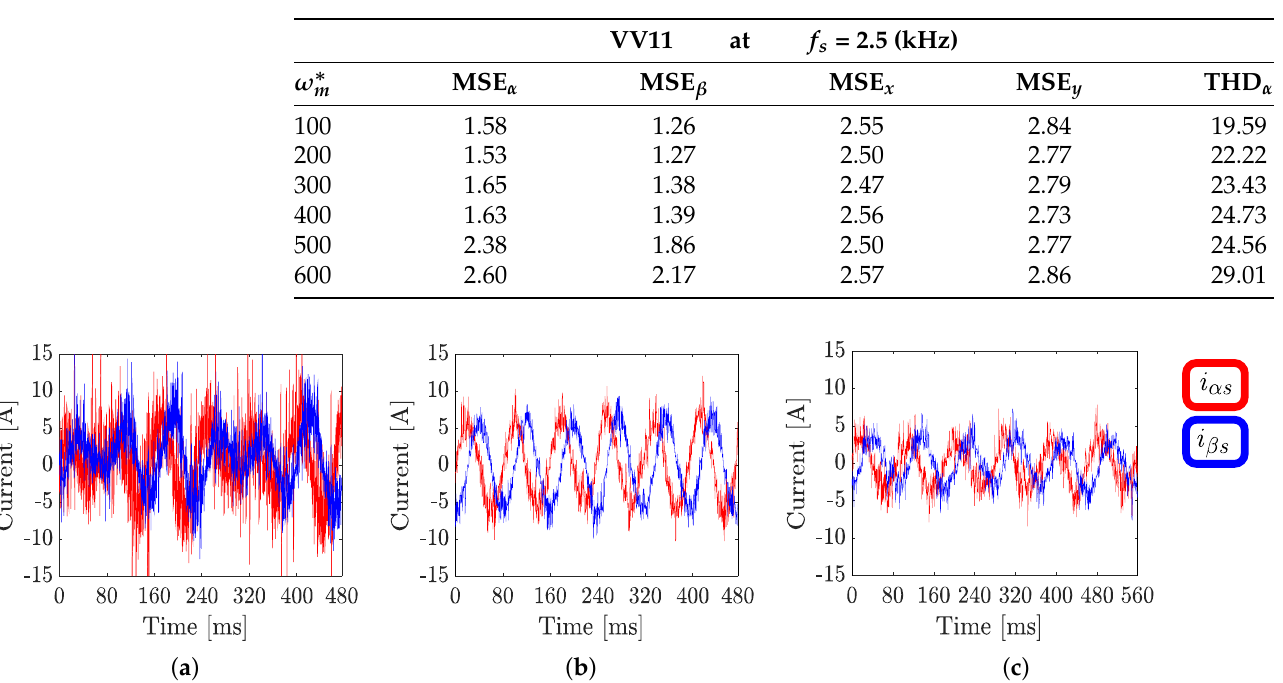
Figure 8. Performance of stator currents in α – β plane for a rotor speed of 200 (rpm) at 2.5 (kHz) of sampling frequency: